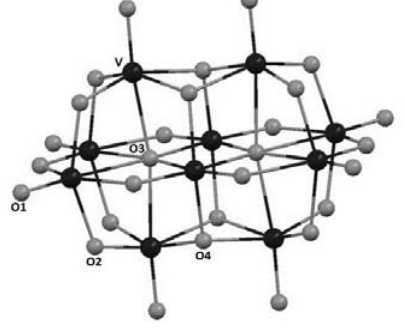
6- structural unit O 10 28